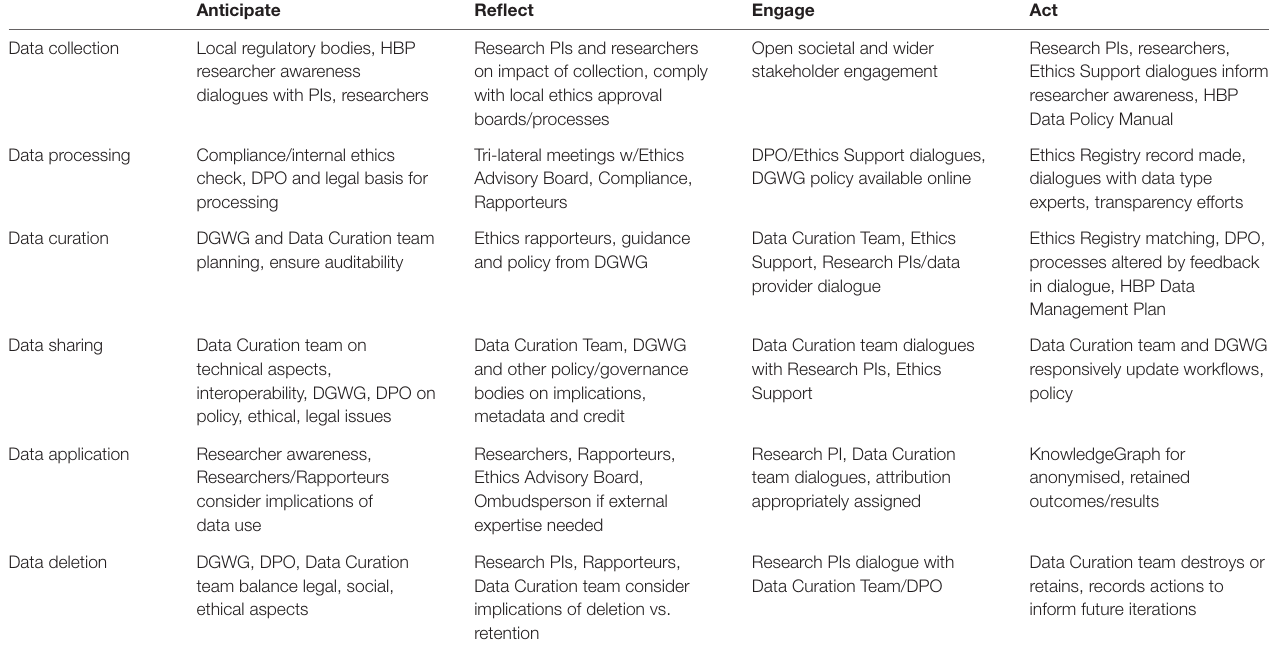
TABLE 2 | Examples of HBP-specific structures, roles, dialogues, and relationships supporting “responsible data governance” throughout the data lifecycle, arranged by the AREA RRI